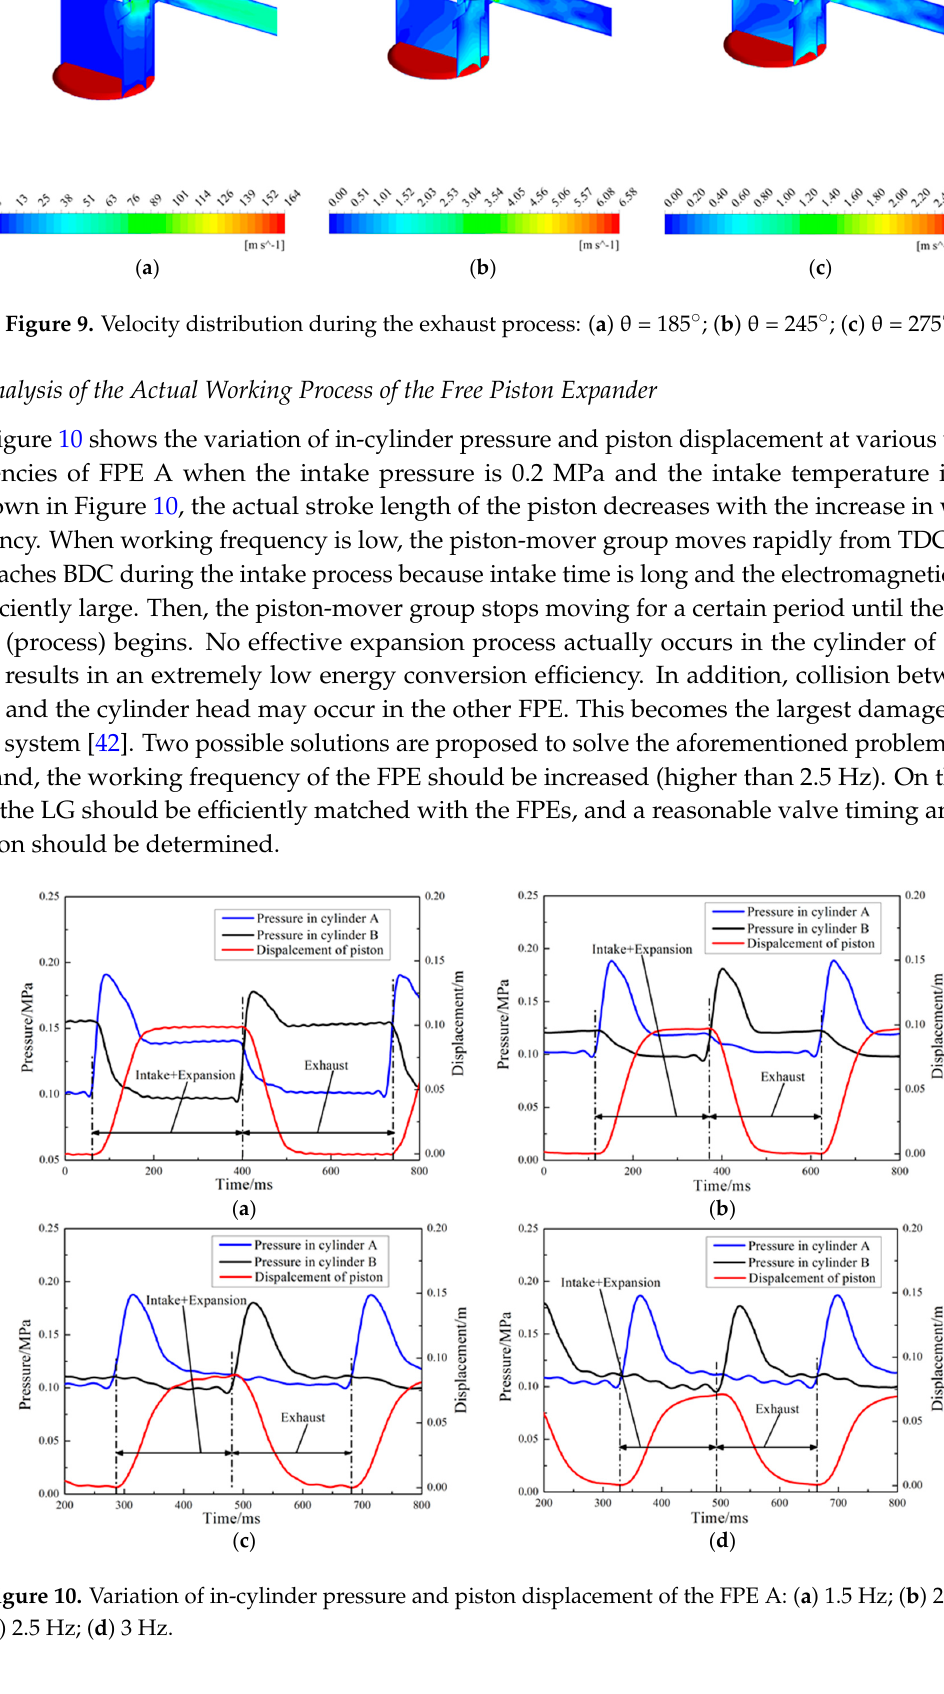
Figure 9 shows the gas velocity distribution during the exhaust process at different cam plate